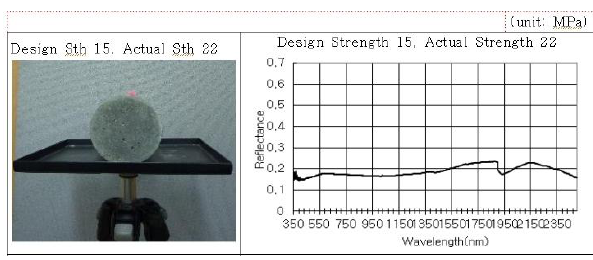
Figure 3. The example of reflectance curve of concrete